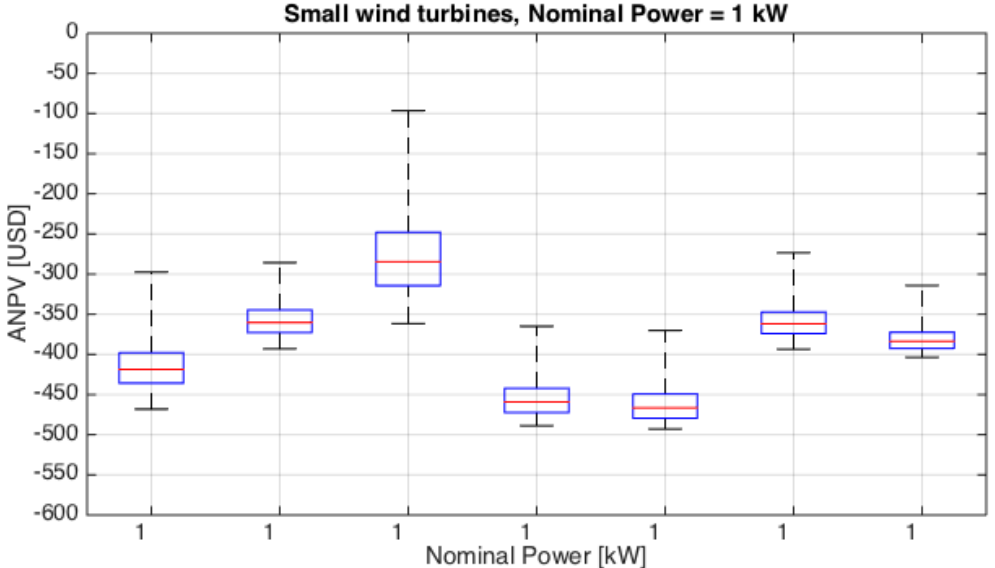
Figure 12. Here, only the seven SWT models with a nominal power of 1 kW are plotted. The highest and lowest data dispersion intervals observed are approximately 250 and 100 [USD], observed for the third and seventh wind turbines from left to right,